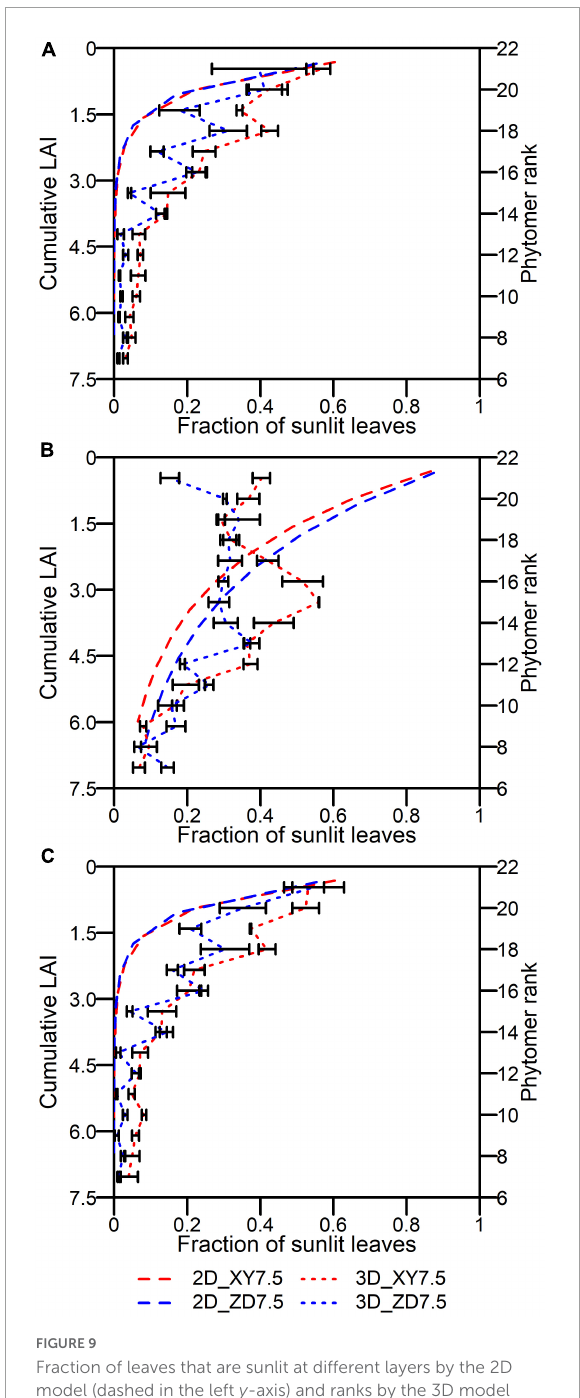
FIGURE9 Fraction of leaves that are sunlit at different layers by the 2D model (dashed in the left y -axis) and ranks by the 3D model (dotted in the right y -axis) over canopy at 6:00 (A) , 12:00 (B) , and 17:00 (C) for ZD958 (blue) and for XY335 (red) at the density of 7.5 plants m - 2 on an overcast day. Error bars indicate the